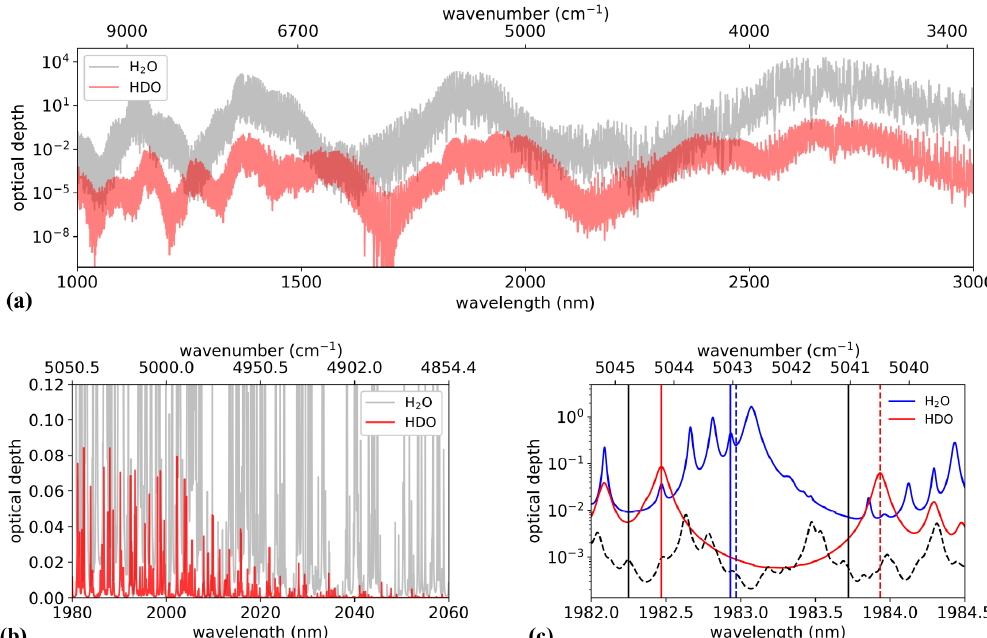
Figure 1. Optical depth over 1km for H 216 O (H 2 O) and HD 16 O (HDO) with uniform volume mixing ratios of 8400 and 2.6ppmv, respec- tively (relative humidity of 50% at 15 ◦ C). (a) Spectral overview between 1 and 3µm. (b) Close-up window for wavelengths around 2µm with decreasing HDO absorption towards 2.05µm. (c) Spectral range of interest for simultaneous H 2 O and HDO sounding. The dashed black line represents the total optical depth of other species (CO 2 , CH 4 , N 2 O) with their typical atmospheric concentrations. Vertical black lines indicate the positions of possible off-line wavelengths. On-line wavelengths are indicated for H 2 O (vertical blue line for option 1 at 1982.93nm, dashed blue line for option 2 at 1982.97nm) and HDO (vertical red line for option 1 at 1982.47nm, dashed red line for option 2 at 1983.93nm). Spectra calculations are based on the HITRAN2016 database assuming a temperature of 15 ◦ C and an atmospheric pressure of 1013.25hPa. Table 1. Spectroscopic parameters for selected absorption lines. ν λ S E (cid:48)(cid:48) γ air n air H 216 O (1) 5043.0476 1982.928 2 . 17 × 10 − 24 920.21 0.0367 0.49 HD 16 O (1) 5044.2277 1982.464 91.33 0.71 HD 16 O (2) 5040.4937 1983.933 H 216 O at HD 16 O (1) 5044.2300